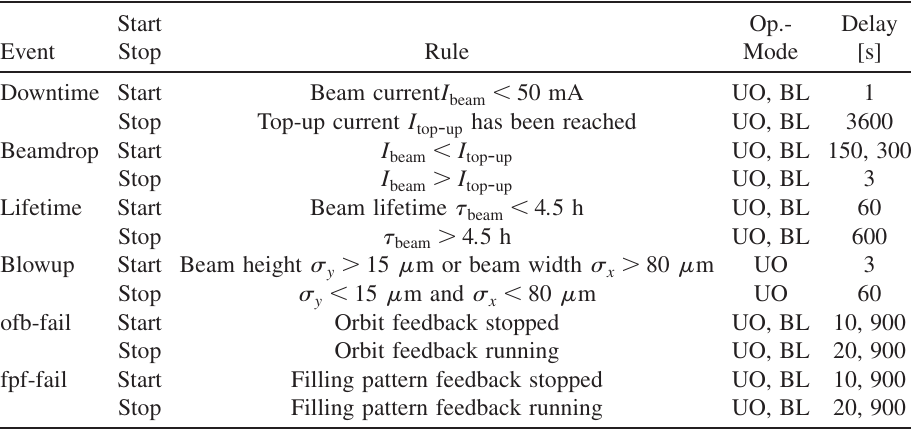
TABLE IV. Event rules defined for the